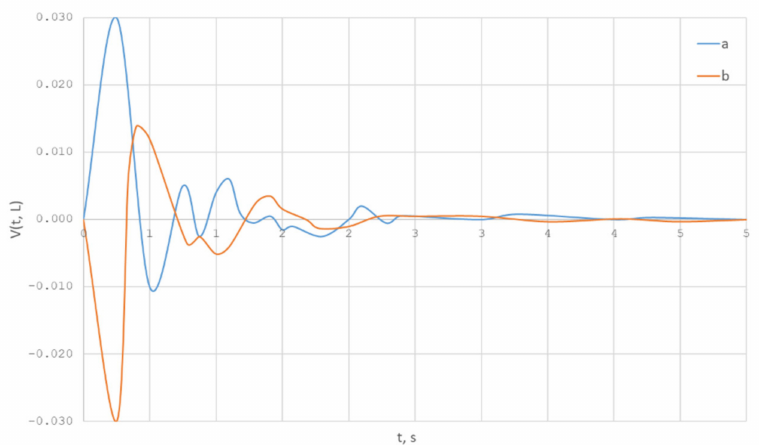
Figure 19. Optimal control